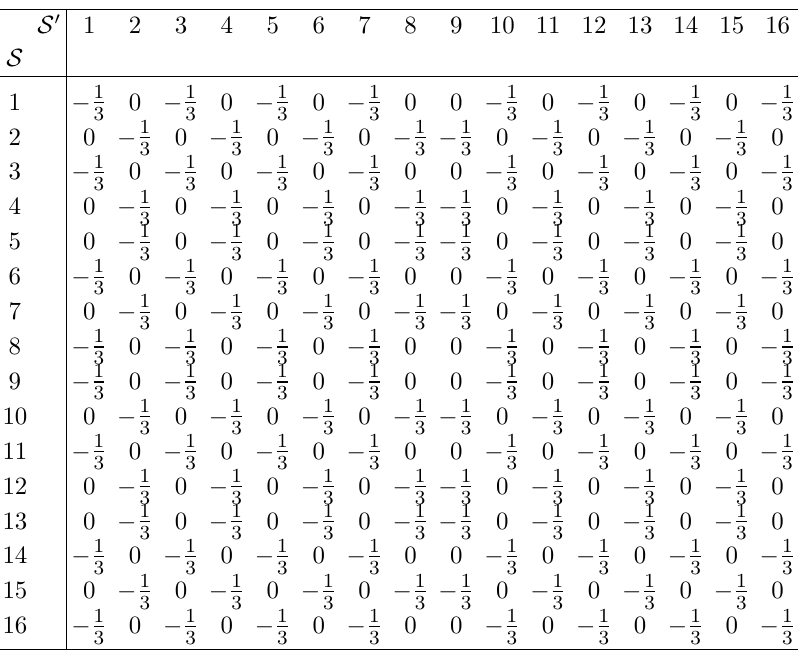
(cid:2) P with di(cid:11)erent boolean factors. [2] [3]